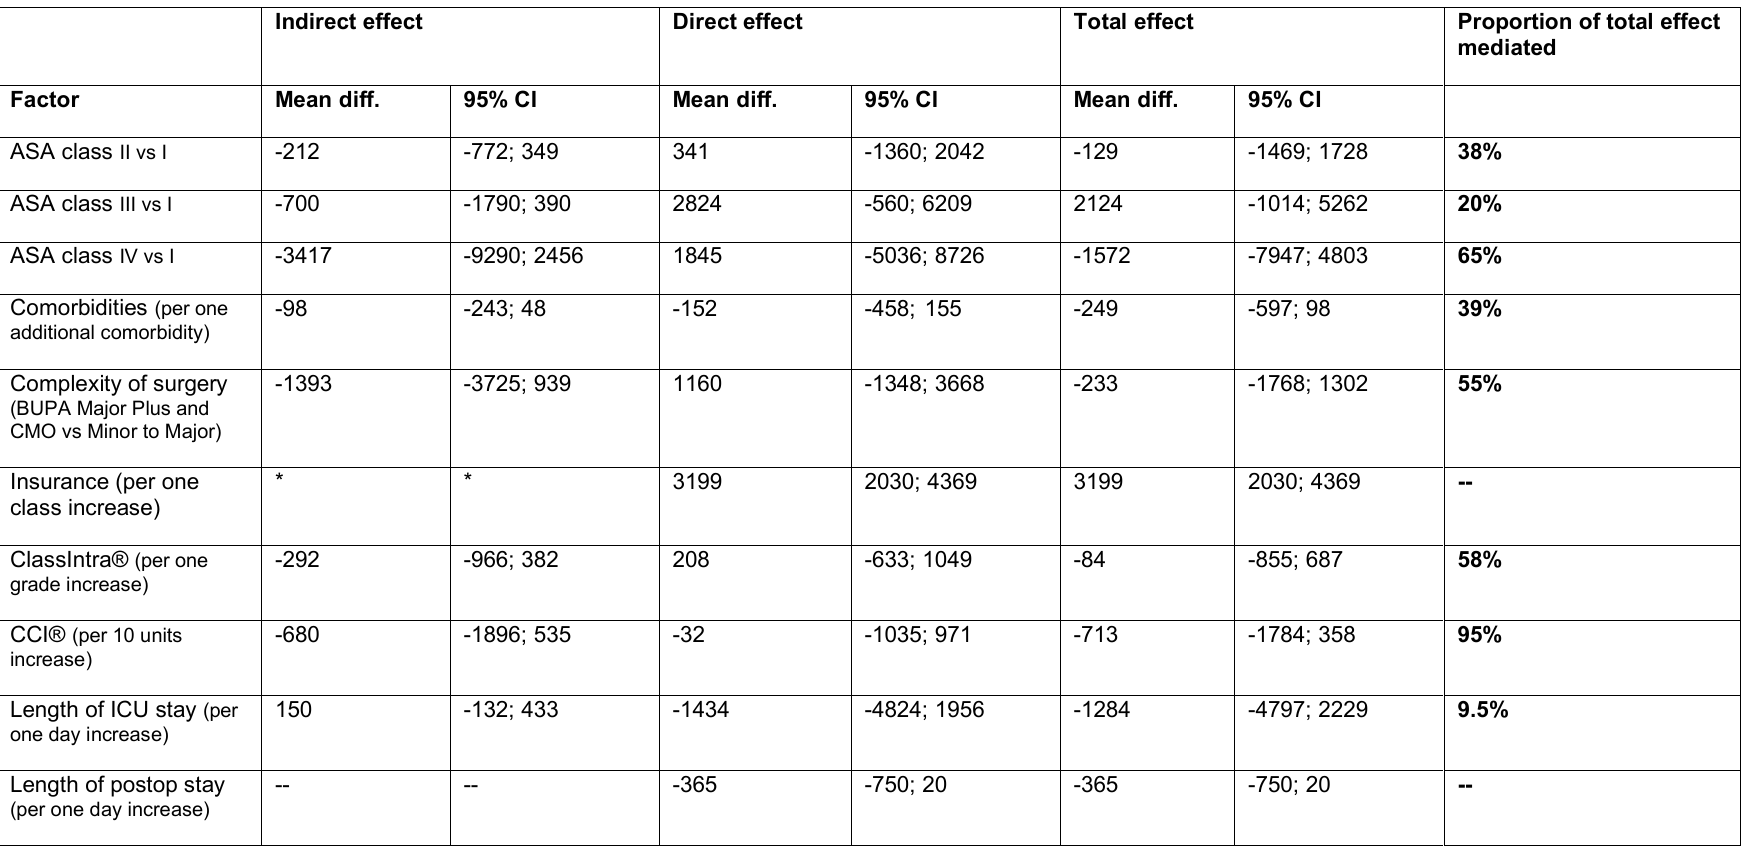
Table 9: Reimbursement model excluding recurrent patients and patients with a protracted hospital or ICU stay (in Euros) Indirect, direct and total effects on reimbursement. Coefficients are mean differences in reimbursement; patients with protracted hospital or ICU stay were excluded in order to meet the linearity assumption. R-squared 58.6%